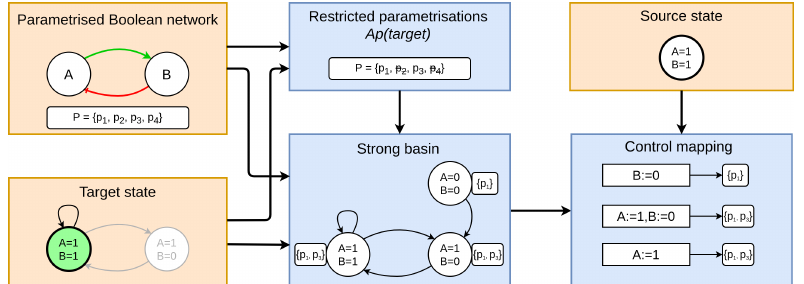
Figure 5. Workflow of computing the source-target control problem. Parts in the orange boxes represent inputs and blue boxes represent (intermediate)